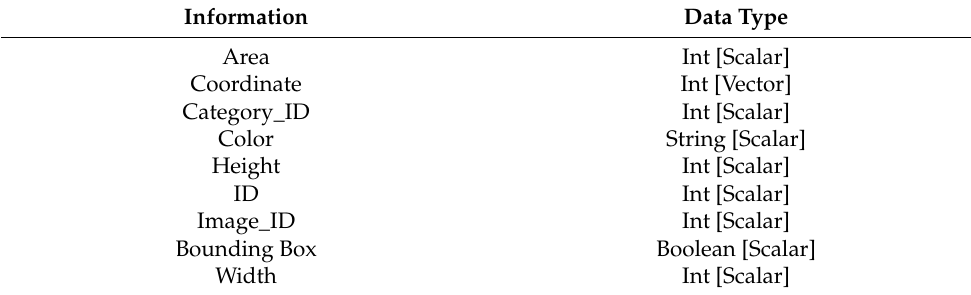
Table 1. Labeled data in json format.